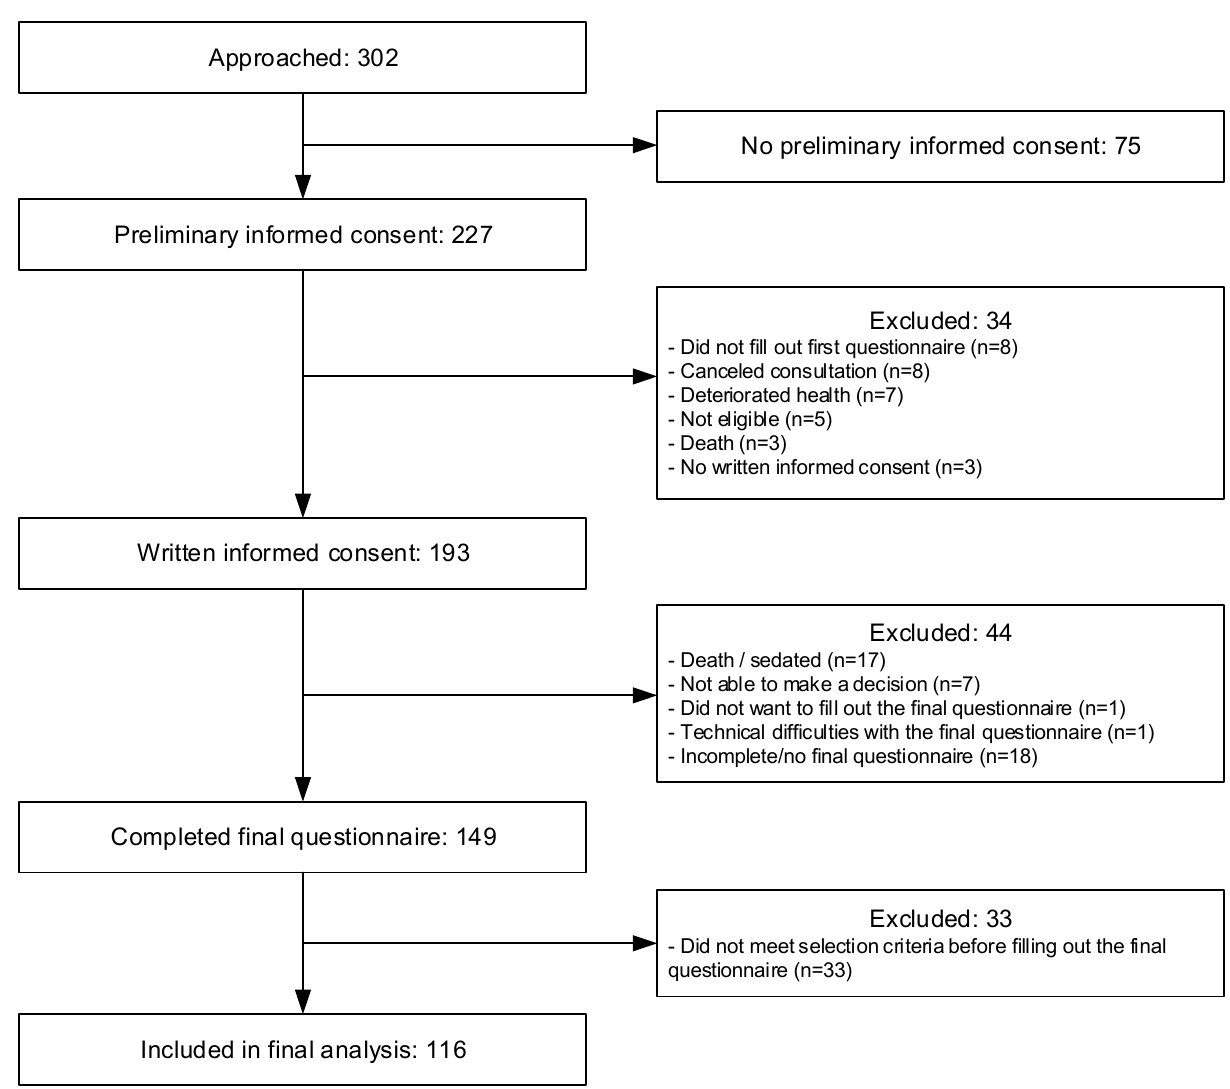
Figure 1. Flowchart for the inclusion of patients. Table 2. Patient characteristics ( n = 116).